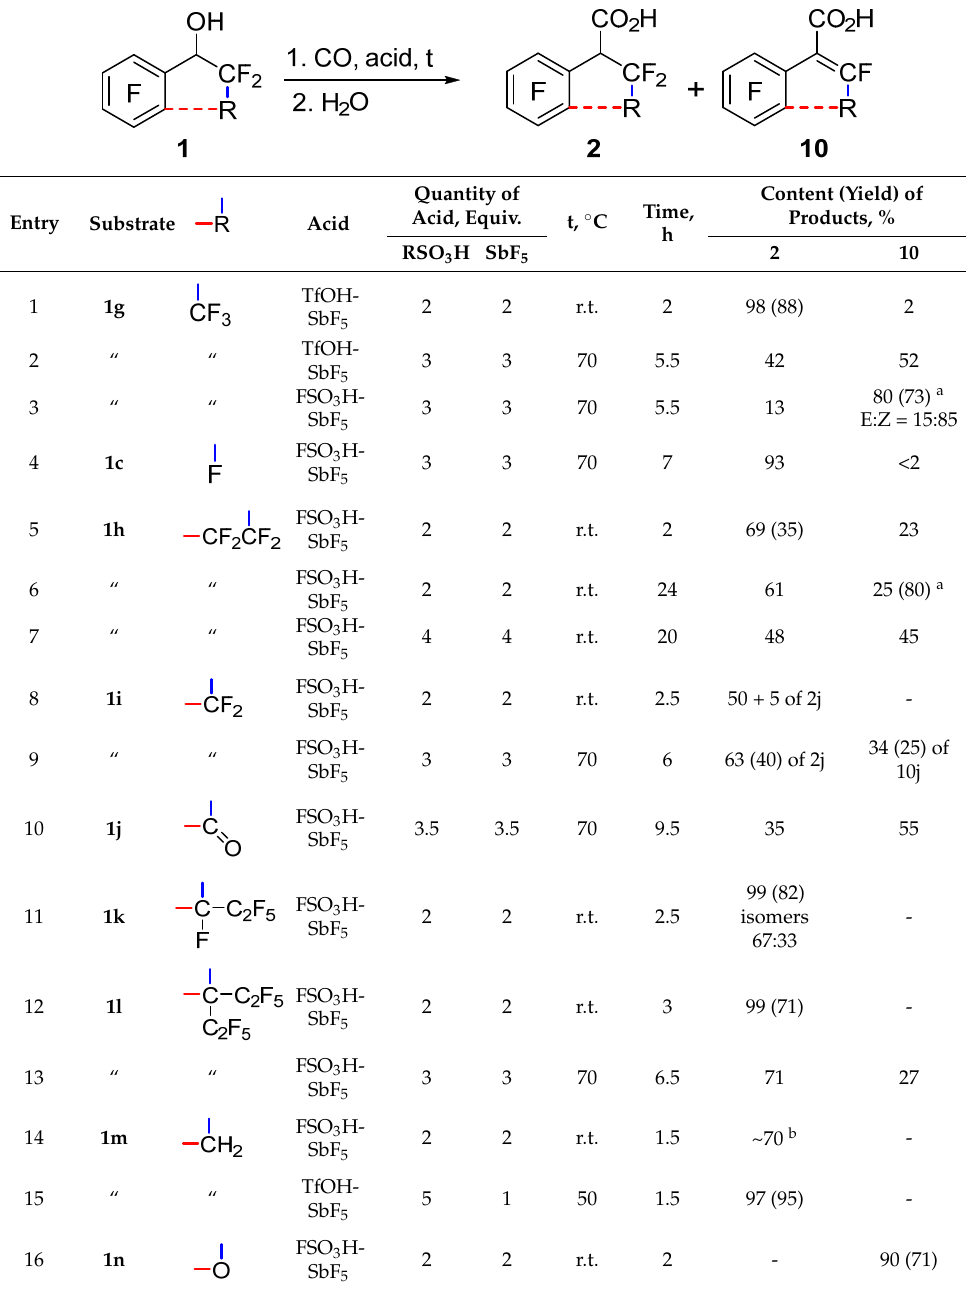
Table 3. Carbonylation of secondary polyfluorinated 1-arylalkan-1-ols 1g – n in superacids.